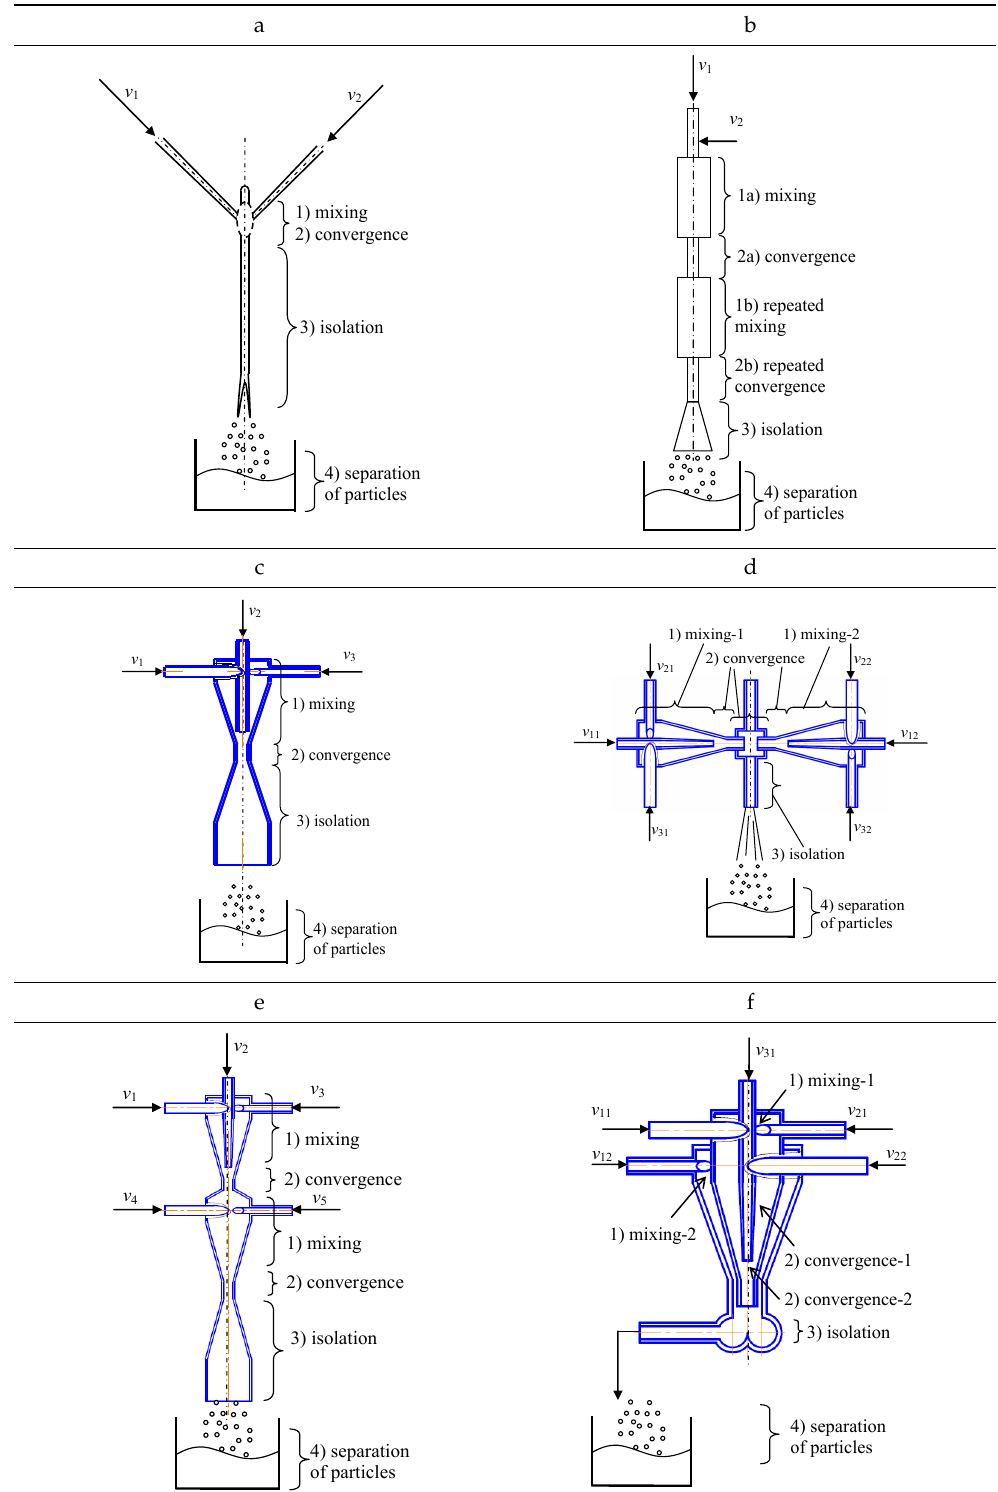
Figure 2. Spatial and temporal levels of formation of nanosized particle. Table 1. Examples of the implementation of processes for the synthesis of nanosized particles in microreactors of various types.